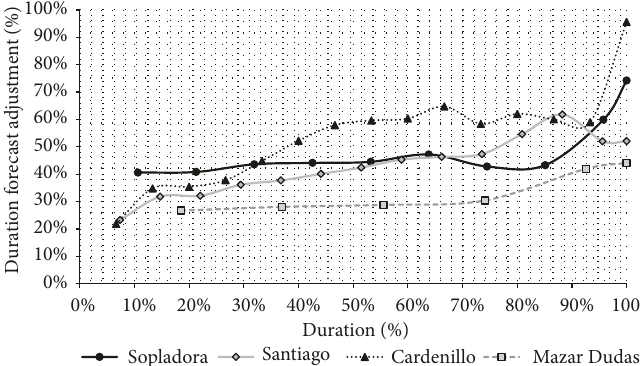
Figure 9: Accuracy of duration forecasts using Earned Schedule over the execution period of the four